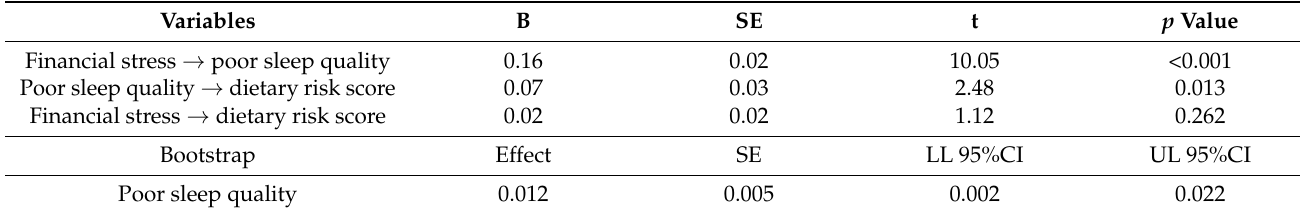
Table 6. Model 1 Mediation Analysis among Students with Poor Sleep Quality.